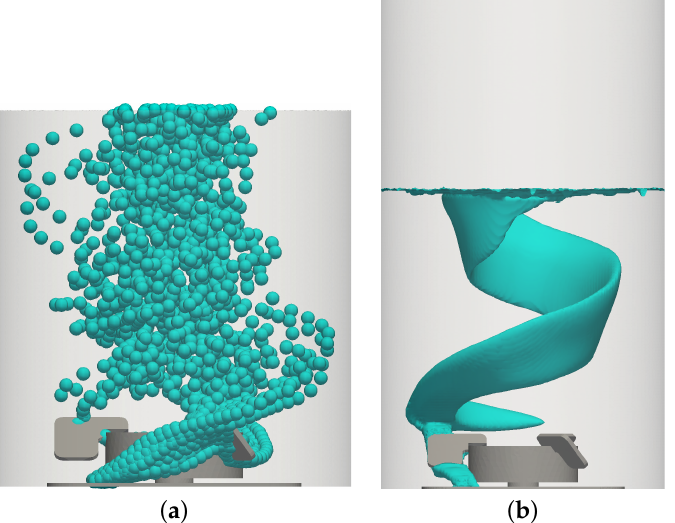
Figure 3. Bubble dispersion for the base condition 4 (7 L, 100 rpm, 0.25 Lmin − 1 , 2 µ m). ( a ) Euler– Lagrange results; ( b ) Euler–Euler results, α g =